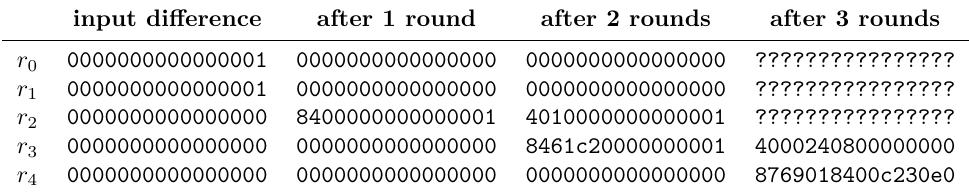
Table 21: Differential characteristic to create forgery for round-reduced Ascon-128a with a 3-round finalization. The differential probability is 2 − 19 . The breakdown of the probability (in − log ) is [4 , 6 , 9]. 2